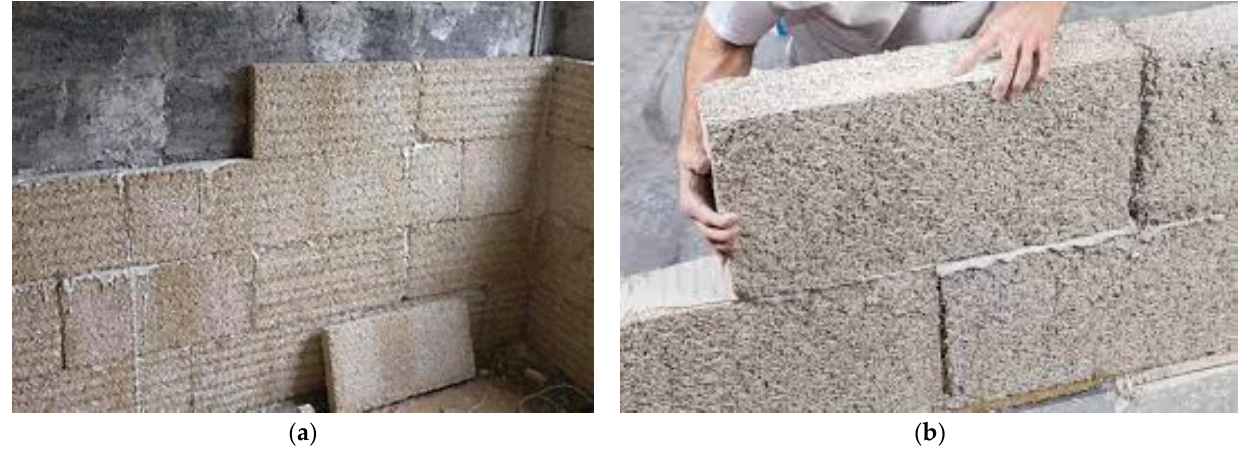
Figure 3. Example of ( a ) hemp blocs and ( b ) positioning of hemp concrete (reproduced from [33]).